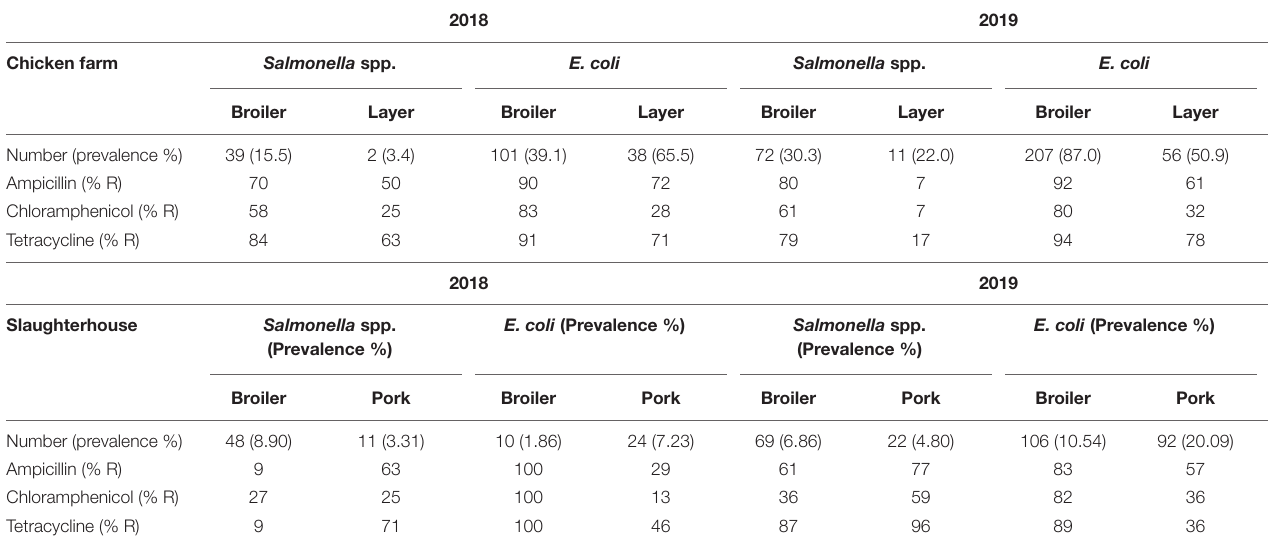
TABLE 2 | Antimicrobial resistance surveillance of Salmonella spp. and Escherichia coli in chicken farms and slaughterhouses (2018–2019) (Department of Veterinary Service [DVS],